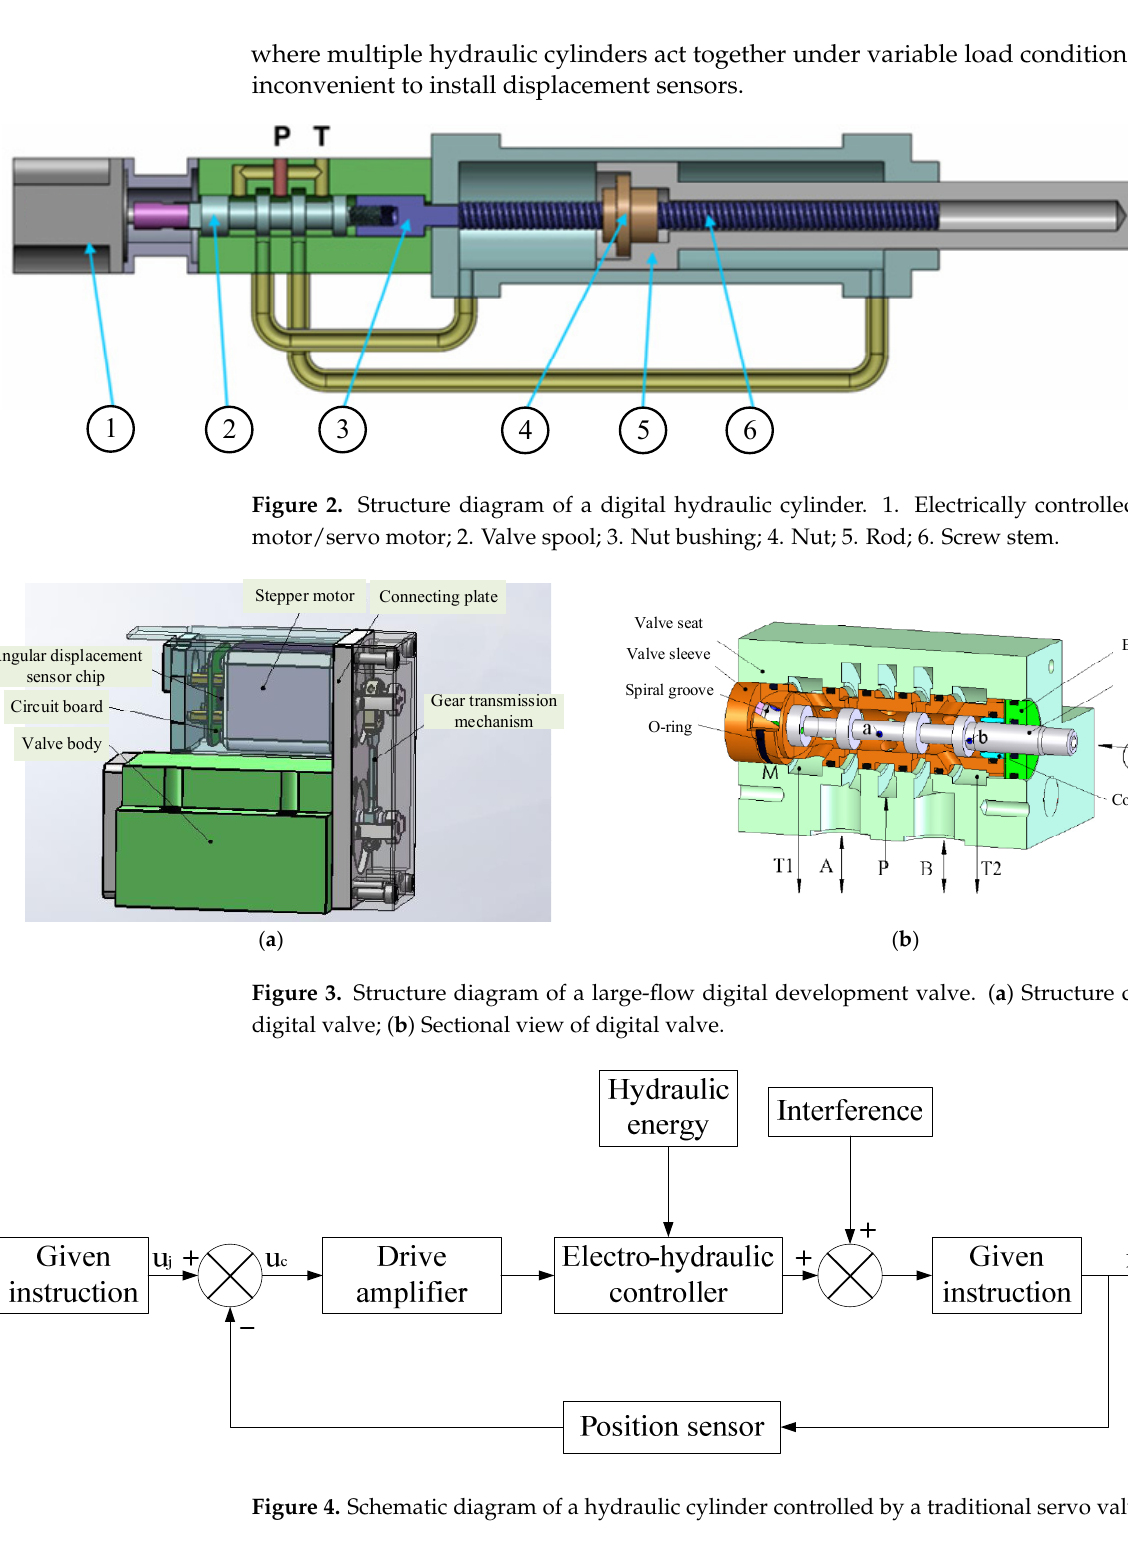
Figure 4. Schematic diagram of a hydraulic cylinder controlled by a traditional servo valve.